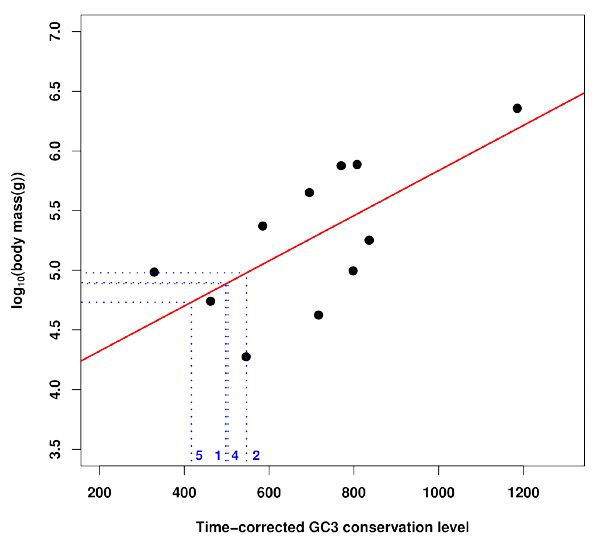
Figure 3 – Relationship between log 10 (body mass) and time-corrected GC3 conservation level. Each dot represents a pair of cetartiodactyl species. The x axis corresponds to γ = t / log ( τ ) , where t is the divergence time taken from TimeTree and τ the the Kendall − rank correlation coefficient. The regression line of log 1 0 (body mass) on time-corrected GC3 conservation level is shown in red. The blue dashed lines show the ancestral body mass predictions for four of the five most basal branches of Cetartiodactyla (branch 3 is not displayed because of its particularly low γ value: 98). Branch labels: see figure